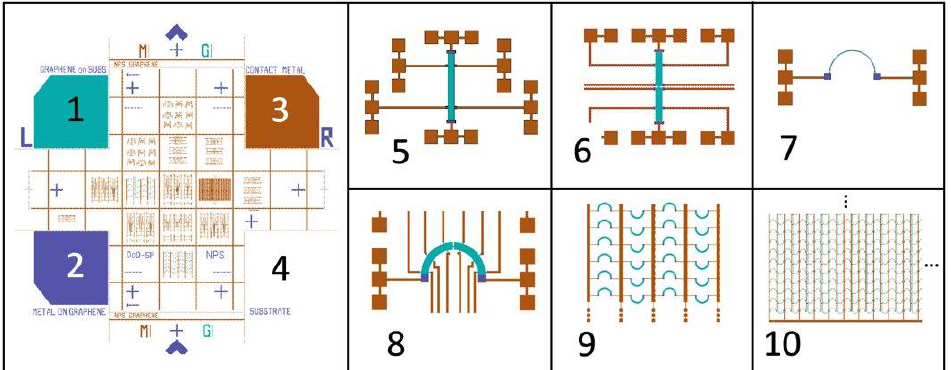
Figure 1. Mask layout and some of the fabricated structures. ( 1 – 4 ) Control areas of: graphene, contact metal on graphene, contact metal, and SiO 2 substrate, respectively. ( 5 ) A 100 μ m × 1000 μ m Hall Bar. ( 6 ) A 100 μ m × 1000 μ m Hall Bar with a 20 μ m constriction. ( 7 ) A 10 μ m × 1000 μ m arc. ( 8 ) A 100 μ m × 1000 μ m arc with a 20 μ m constriction. ( 9 ) A 4 × 4 array of 100 μ m × 1000 μ m arcs. ( 10 ) Section of a 44 × 85 array of 5 μ m × 100 μ m arcs.